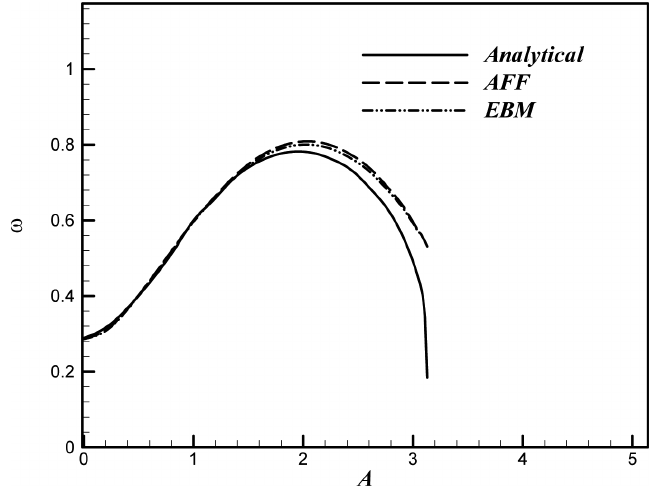
Fig. 2. Comparison of periods between three methods (case